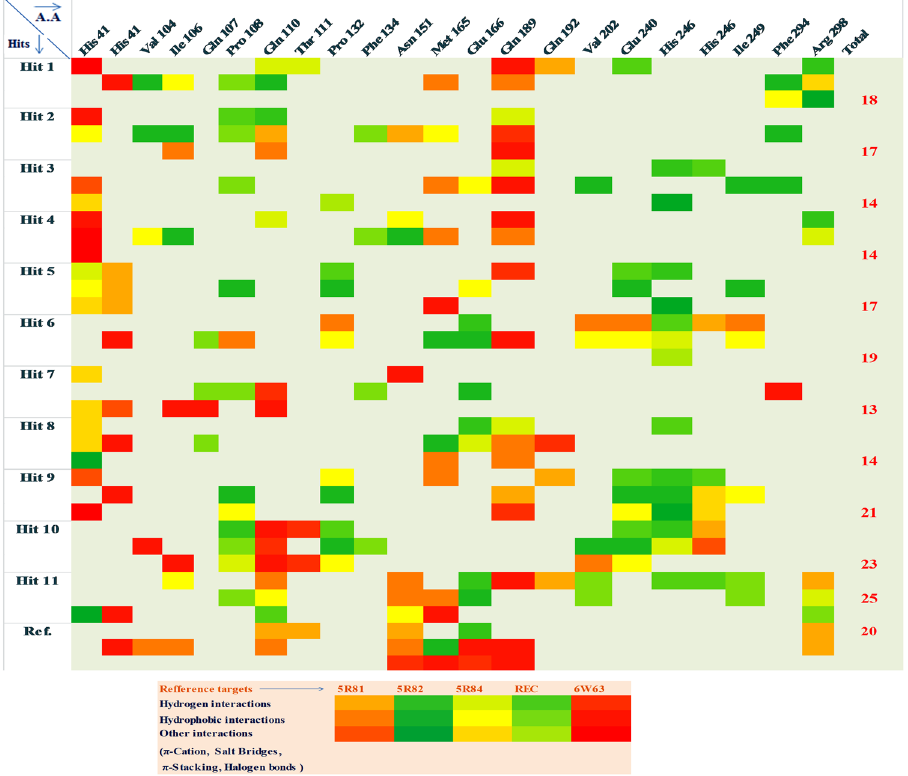
Figure 7. Hit map analysis depicting the interaction profile of screened